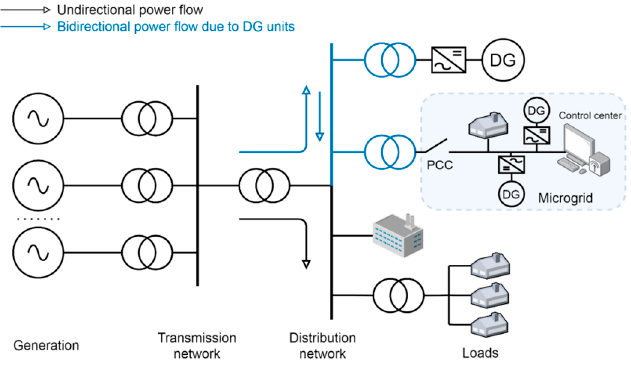
Figure 1. Converter-interfaced generation (CIG) integration into the existing electrical